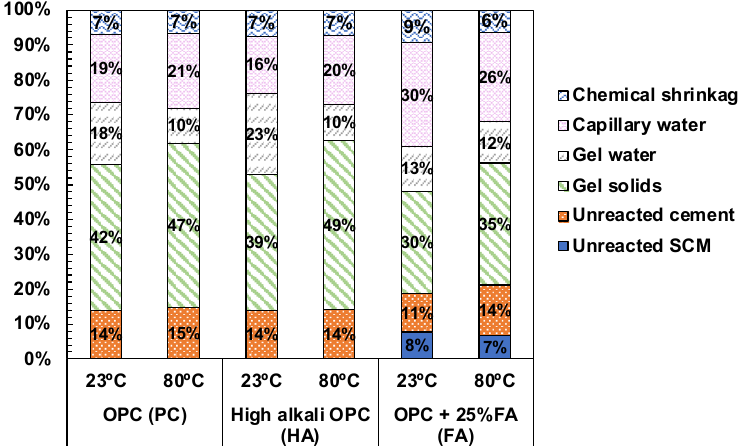
Figure 2. Pore partitioning model results showing unreacted binder, gel solids, gel water, capillary water, and chemical shrinkage volume percentages.